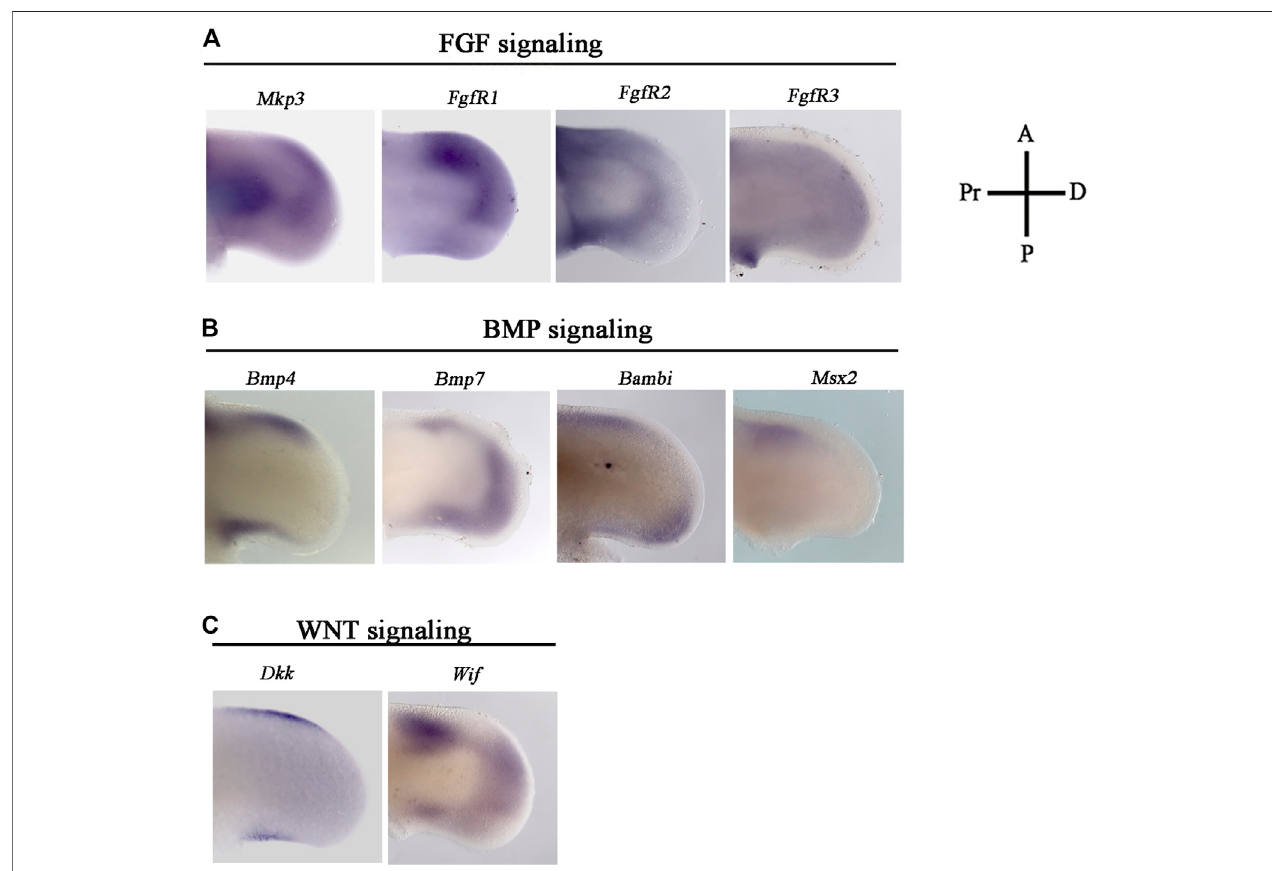
FIGURE 2 | Gene expression pattern of effector genes related with WNT, FGF, BMP signaling in the ANZ and PNZ. Cell death pattern and in situ hybridizations of (A) Mkp3, Fgfr1, Fgfr2, Fgfr3, Bmp4, Bmp7, Bambi, Msx2, Dkk, and Wif. They were evaluated in the anterior margin of the limb at developing stage 24 HH. (A) Mkp3, Fgfr1 , Fgfr2 ,and Fgfr3 aregenesrelatedtoFGFsignaling. (B) Bmp4 , Bmp7 , Bambi, and Msx2 relatedtoBMPsignaling,whereas (C) Dkk,Wif, relatedtoWNTsignaling. Notice the dynamic expression of all genes in the ANZ.